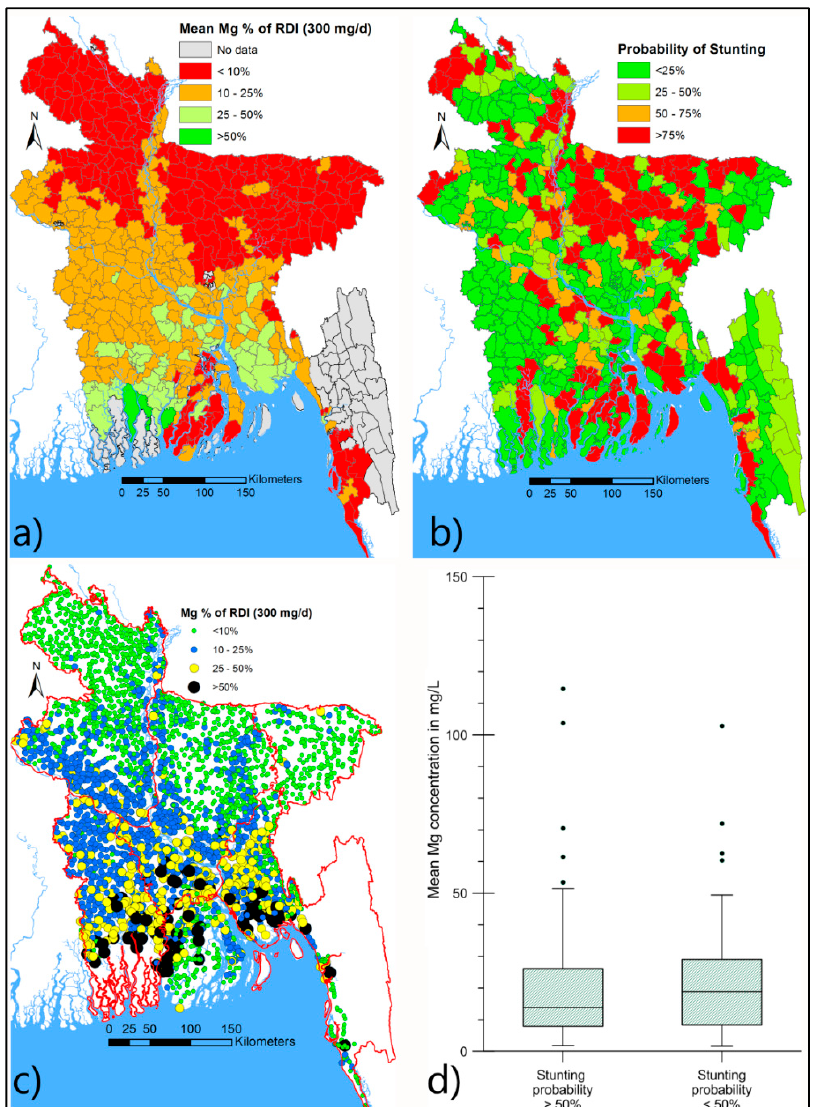
Figure 8. The possible association between tubewell Mg concentration and probability of under-five children stunting in Bangladesh. ( a ) upazila based mean Mg concentration [22] in relation to RDI; ( b ) upazila based probability of stunting in children under-five in Bangladesh (from http://www.foodsecurityatlas.org, accessed 1 August 2014); ( c ) Spatial variation of Mg in well water in Bangladesh, and ( d ) mean Mg concentration in upazilas (panel— a ) where probability of stunting (panel— b ) is > 50% and < 50%.